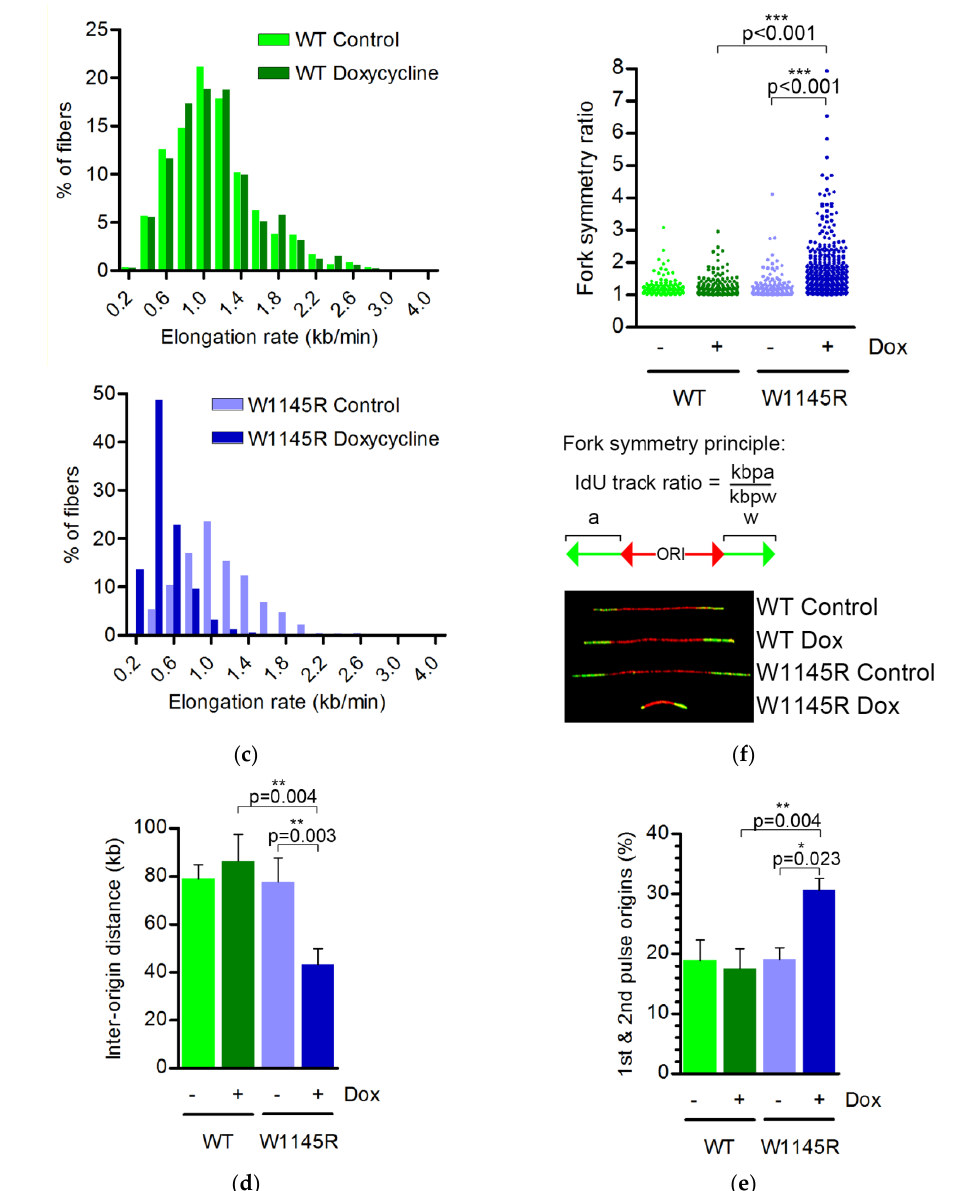
Figure 4. Expression of eGFP-TopBP1 W1145R but not WT causes strong DNA replication stress. ( a ) Scheme for the DNA fiber assay; ( b ) DNA replication fork elongation rate (kb min −1 ); ( c ) The distribution of elongation rate data from panel B; ( d ) Distance between origins (kb); ( e ) Percentage of new origins initiated during both pulses; ( f ) Whisker plot showing fork symmetry ratios in individual fibers. The principle for counting fork symmetry ratios, and examples of representative fibers are shown. For this analysis, we used longer labeling times (45 min instead of 20 min) as it gives longer tracks which are easier to measure. Mean values and standard deviations are shown in panels ( b , d , e ). The data are from three technical repeats from two independent experiments. For each experiment, 129 to 953 fibers were scored. Statistical significance was calculated using paired samples (when comparing W1145R −Dox vs. +Dox) or unpaired samples (WT +Dox vs. W1145R −Dox) two-tailed Student’s t -tests in panels ( b , d , e ), and a Mann–Whitney test in panel ( f ), using the averages of the individual experiments. *, ** and *** indicate p values below 0.05, 0.005 and 0.001, respectively. Representative images of DNA fibers are presented in Figure S1.